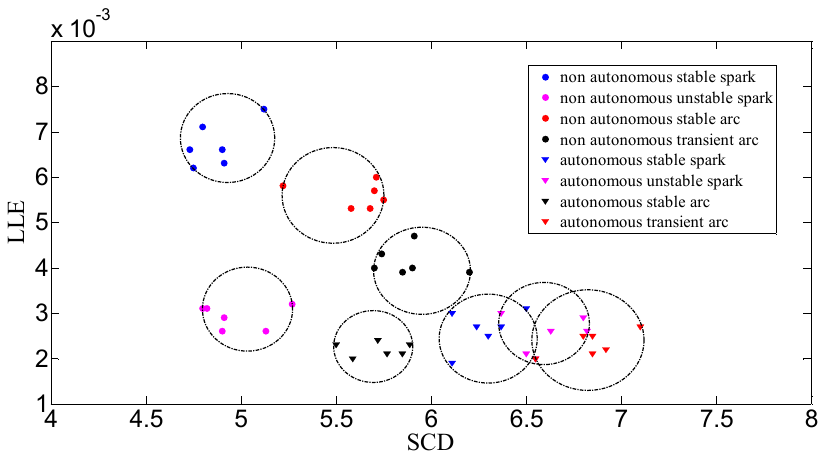
Figure 7. The distribution of relationship between LLE and SCD.